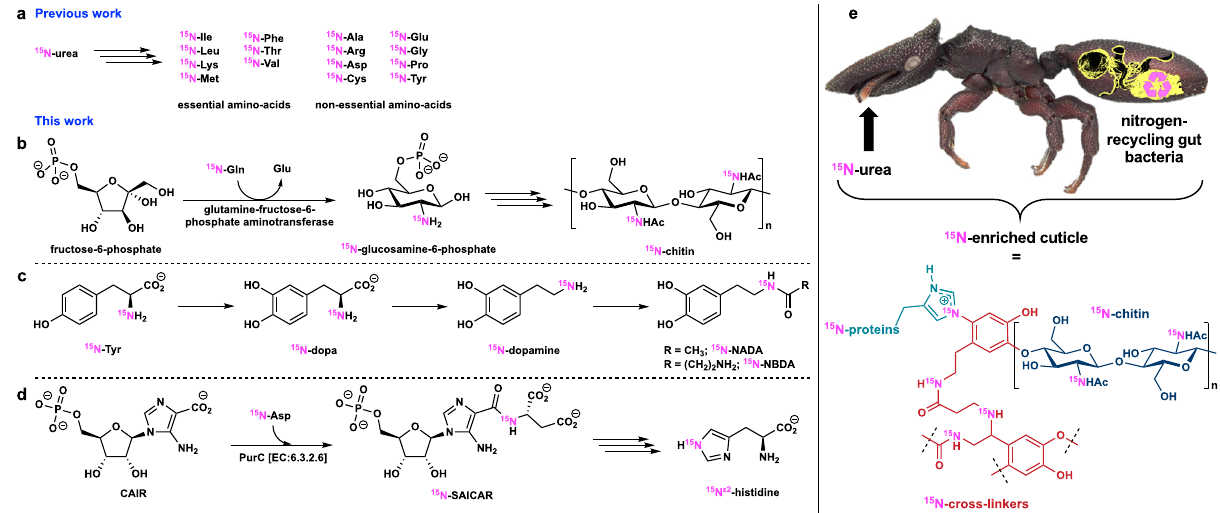
Fig. 2 Gut bacteria contribution in nitrogen fl ux. a Biosynthetic pathways impacted by gut bacteria in the production of amino acids from previous work 15 and molecular components of the cuticle inferred in this study ( b – d ). e Overall representation of gut bacteria contribution to ant cuticle (proteins, chitin, and cross-linkers are shown in different colors). Enriched nitrogen is represented in pink. Ant photograph used with permission from the Field Museum of Natural History (FMNHINS 0000 062